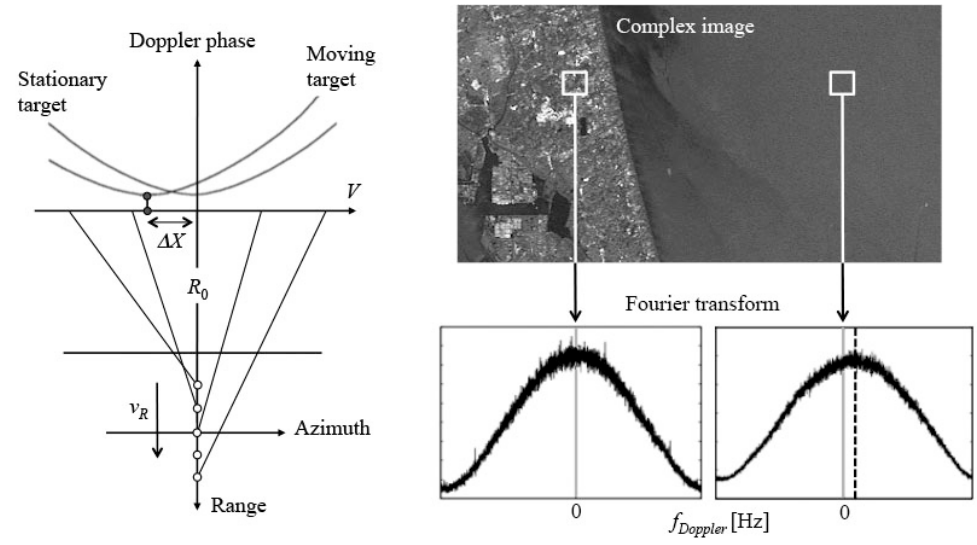
Figure 21. Principle of current velocity measurements by the Doppler shift. Left : the center of the azimuth return signal from a range moving scatterer is shifted. Right : The center of the spectrum over the sea surface is shifted from that of the stationary surface.